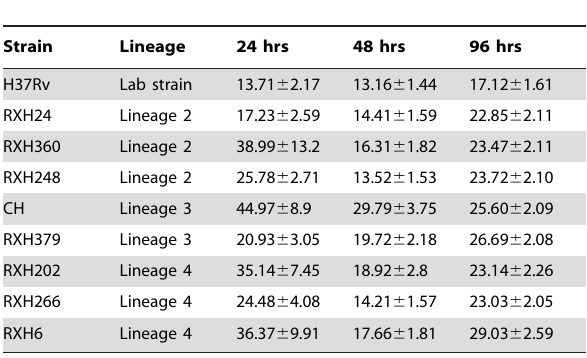
Table 3. Doubling time + for M. tuberculosis strains from different lineages in human monocyte derived